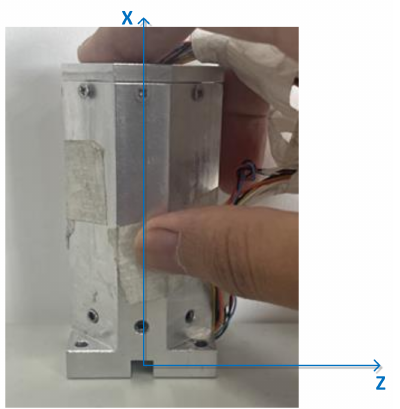
Figure 13. Position 2 in the TPC method.